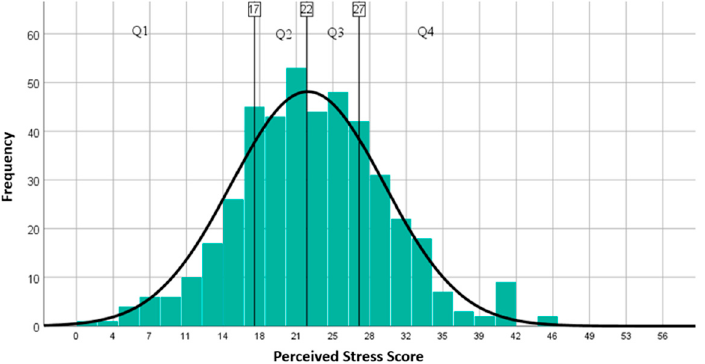
Figure 6. Perceived Stress Level. Q1 = lowest quartile (1 to 25%) scored between 1 and 17; Q2 = the second quartile (26 to 50%) scored between 18 and 22; Q3 = the third quartile (51–75%) scored between and 33; Q4 = the top quartile (76–100%) scored between 33 and 40. Table 5. Correlation between demographic characteristic and scale Respondents living in the urban areas reported higher stress levels ( p = 0.011) and lower resilience ( p = 0.008) than respondents from the countryside. Lower level of educa- tion is statistically significant correlated with anxiety symptoms, perceived stress, and low resilience. Furthermore, unemployed and retired respondents associated higher anxiety